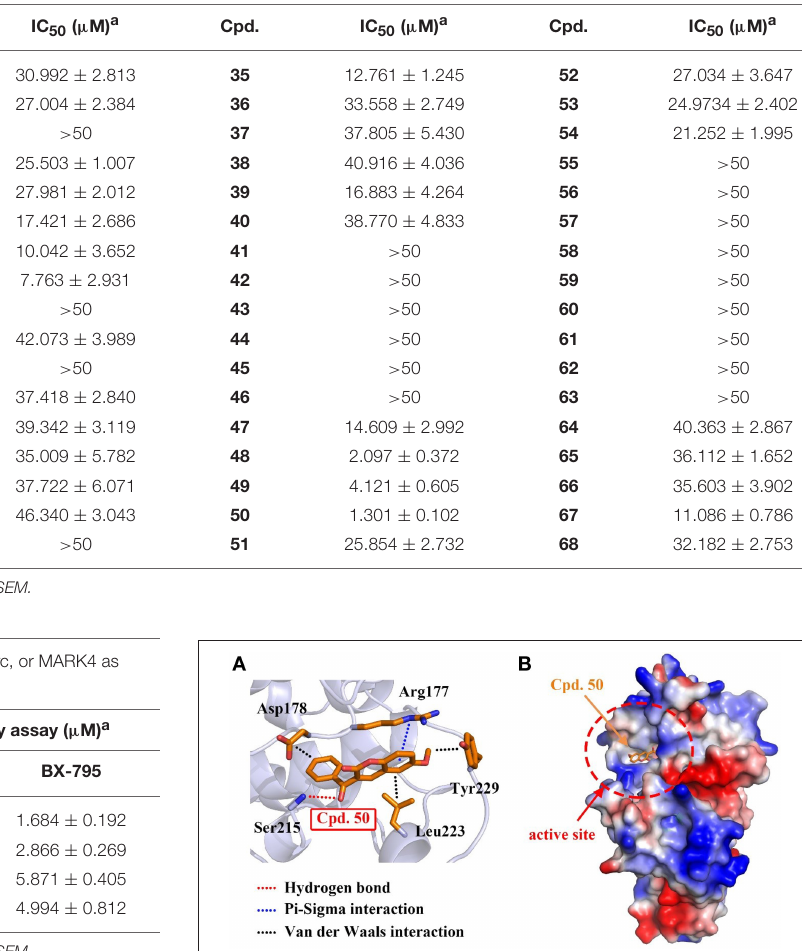
FIGURE 3 | Compound 50 located in the active site of MARK4. (A) Flexible docking of compound 50 in complex with MARK4 (PDB ID: 5ES1). (B) Flexible docking results of MARK4 (PDB ID: 5ES1) and compound 50 . The image represented the charge distribution of MARK4 in complex with compound 50